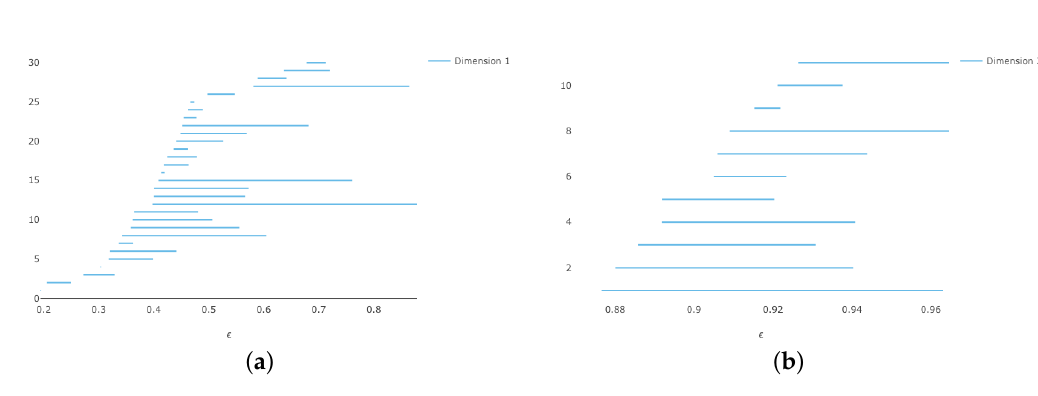
Figure 3. Vietoris–Rips persistence diagrams for 100 points on R P 2 ( a ) H 1 persistence and ( b ) H 2 persistence.